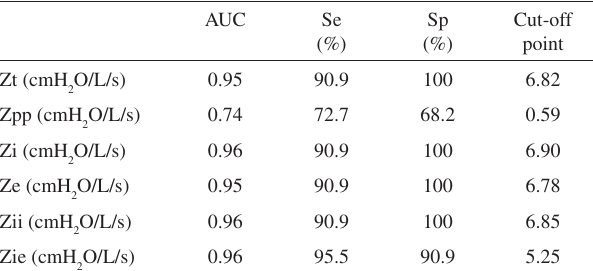
Table 3 - Values of the area under the ROC curve (AUC), sensitivity (Se), specificity (Sp), and respective cut-off points for the FOT